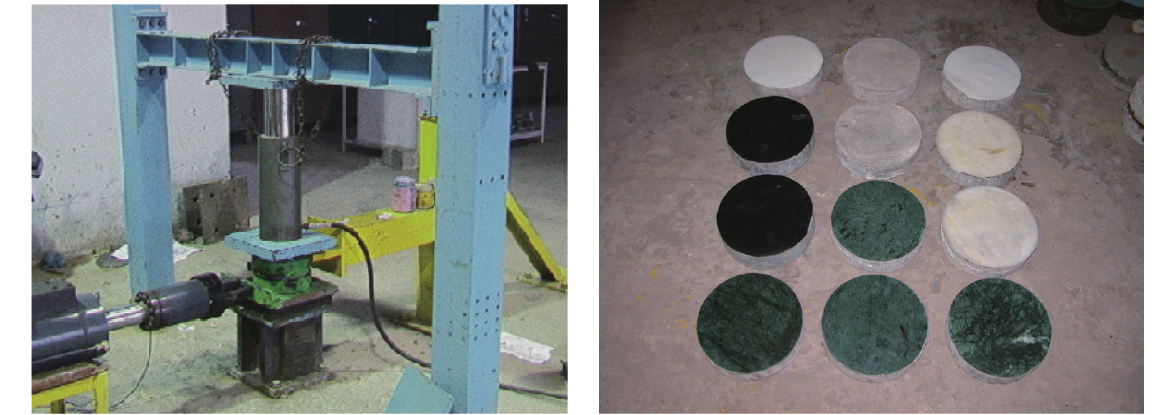
Fig. 2. Experimental set up for friction test with Shear Box (photo- graphic view).